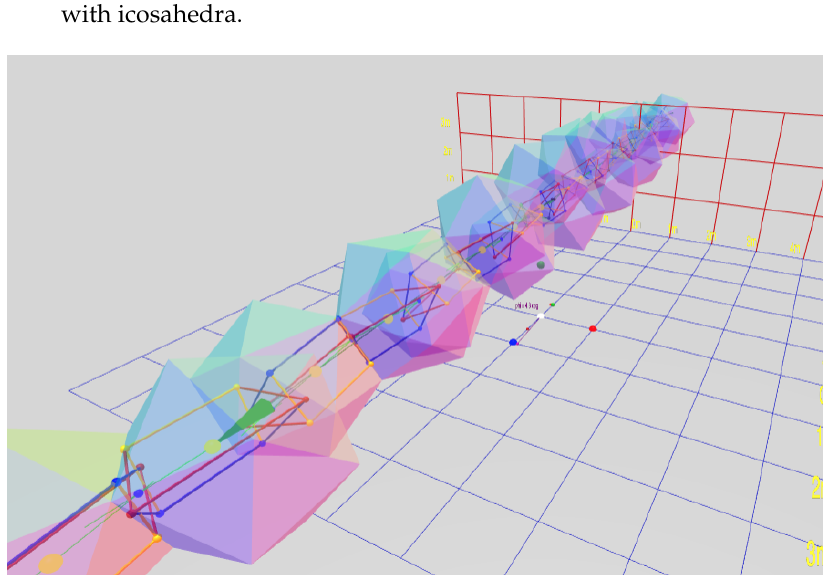
Figure 18. Quasi-planar